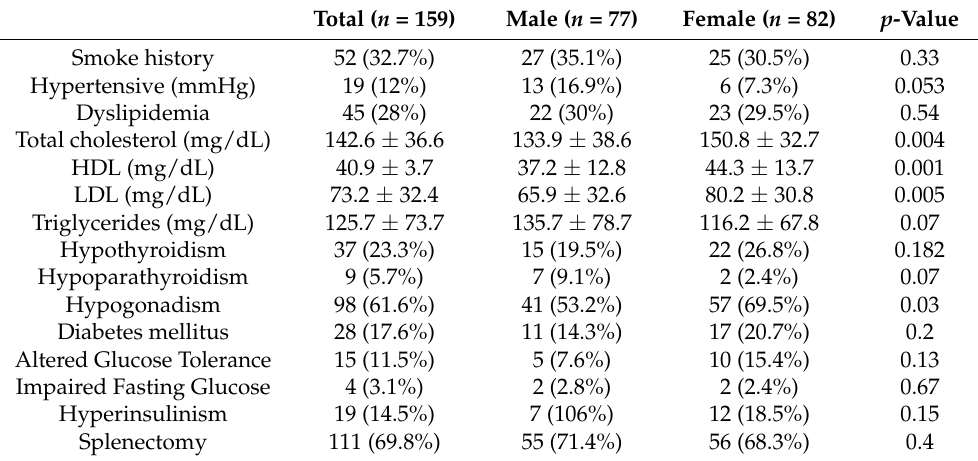
Table 2. Cardiovascular risk factors and comorbidities.